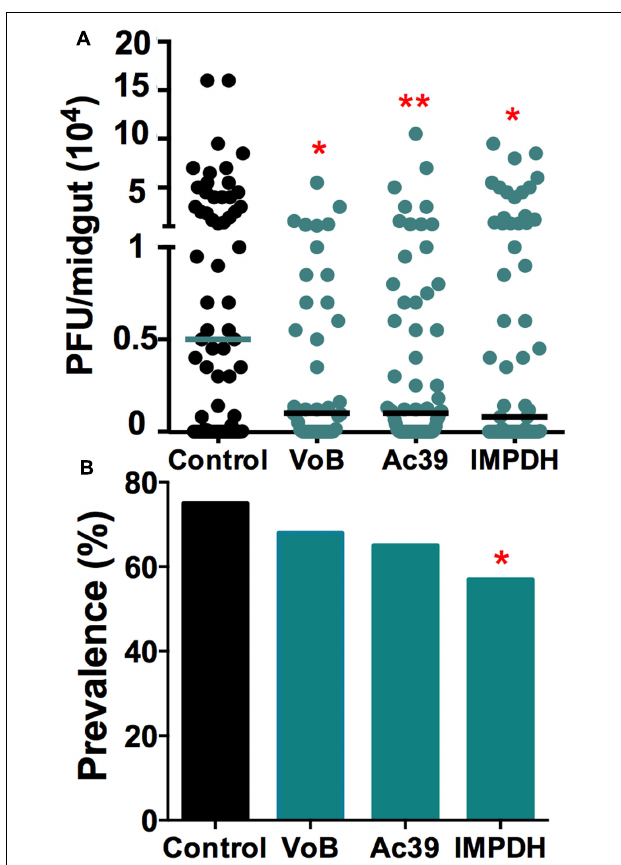
FIGURE 4 | Mosquito host factors influence ZIKV infection. Genes encoding two subunits of the vATPase (VoB and Ac39) ( N = 41, N = 65) and IMPDH ( N = 63) were silenced upon ZIKV infection. (A) Each dot represents the PFUs per midgut in three independent experiments. The bars represent the median. ∗ P < 0.05, ∗∗ P < 0.01; Kruskal–Wallis test. (B) Prevalence (percentage) of infected mosquitoes. ∗ P < 0.05; chi square